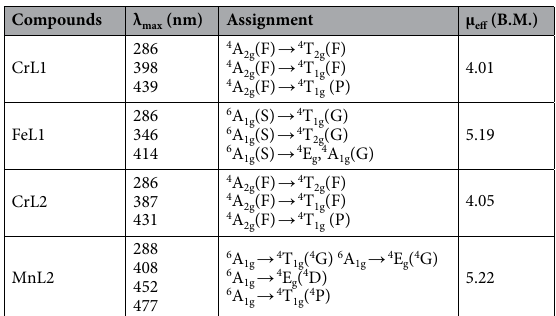
Table 3. UV–vis spectra values of two ligands and their new FeL1, CrL1, CrL2 and MnL2 metal complexes.